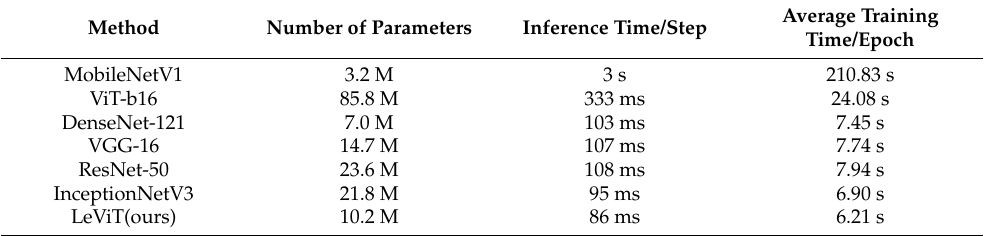
Table 4. Comparison of training costs in